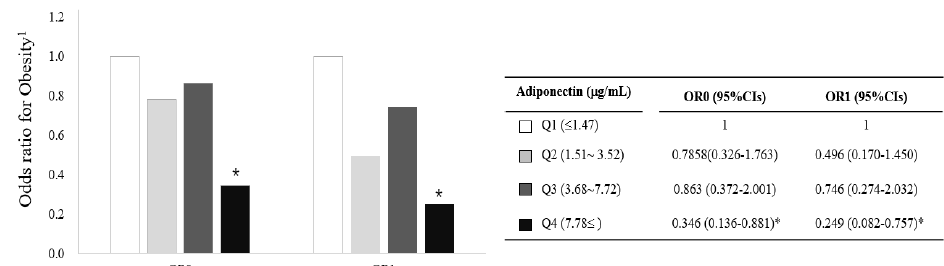
Figure 4. Risk of obesity (BMI ≥ 25 kg/m 2 ) associated with circulating adiponectin concentrations in Korean women. * p < 0.05 compared with the reference group (Q1). The association was calculated using the OR (95% CIs) of a logistic regression model with adjustment for age, smoking, drinking, menopausal status, and total calorie intake; 1 : BMI ≥ 25 kg/m 2 , CI: confidence interval, OR: odds ratio, Q: quartile.